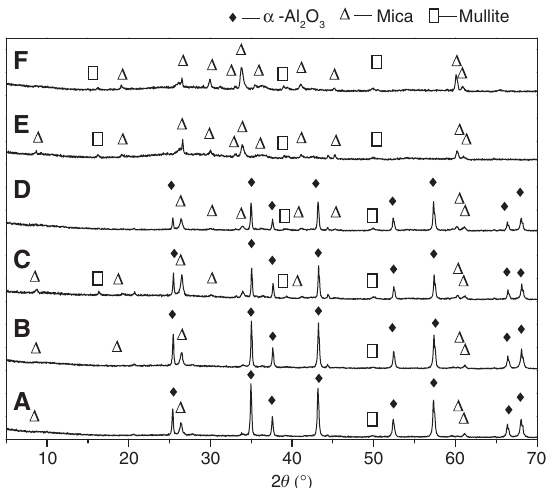
Figure 2: The XRD patterns of different samples varied with average grain size. = 0.94 μ m, parallel to the press axis; (B) D = 0.94 μ m, (A) D 50 50 = 1.29 μ m, parallel to the perpendicular to the press axis; (C) D 50 = 1.29 μ m, perpendicular to the press axis; press axis; (D) D 50 (E) average D = 100 μ m, parallel to the press axis; (F) average D = 100 μ m, perpendicular to the press